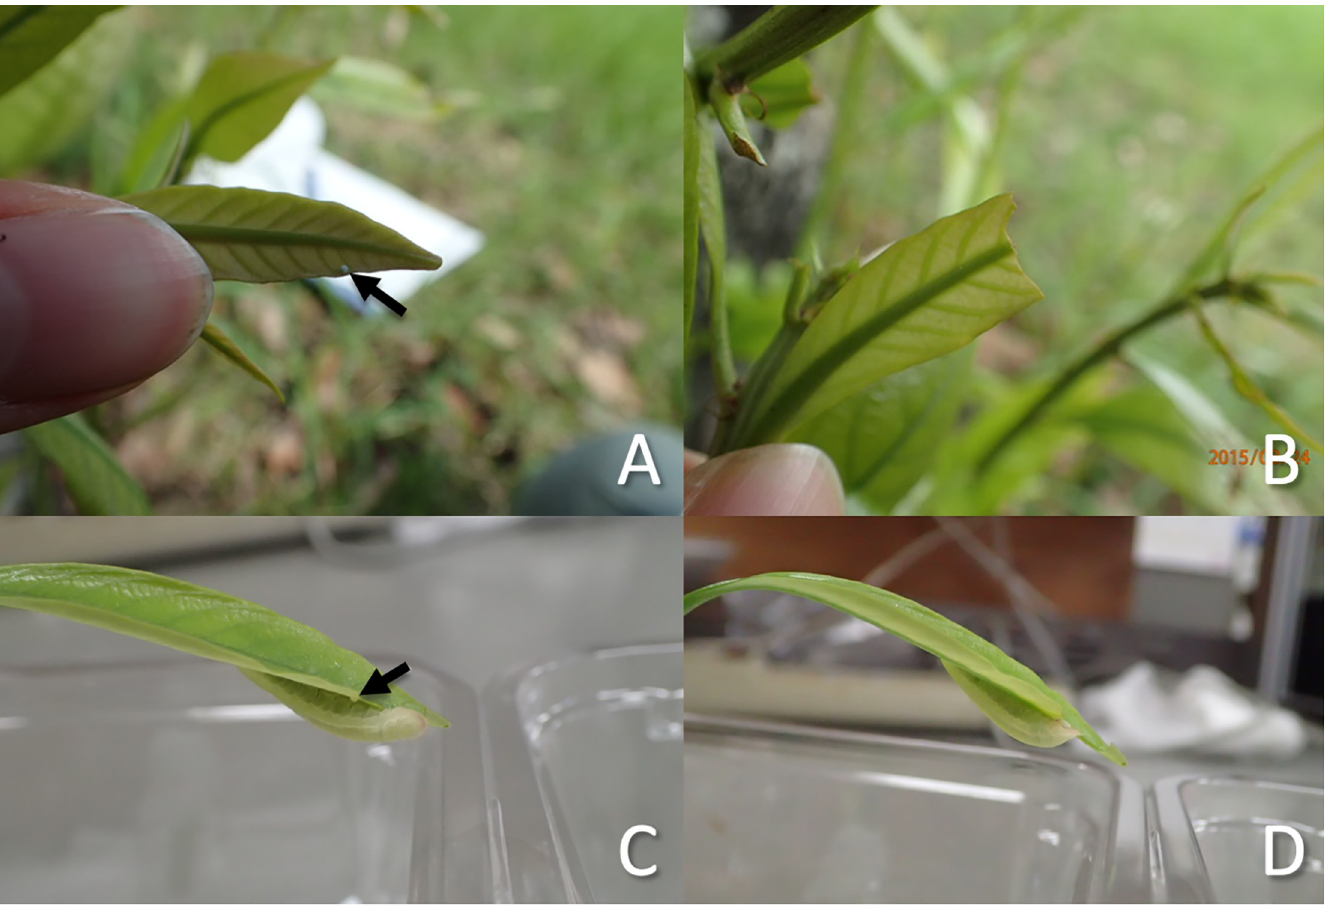
Fig 7. Examples of field (A-B) and laboratory (C-D) observations of A . bazalus eggs. (A) An A . bazalus egg (an arrow) laid on a young emerging L . edulis leaf, and (B) the same leaf, from which the apical part had been eaten and the egg was displaced after two days; a fifth instar A . bazalus larva (C) finding a conspecific egg (an arrow) on the host leaf and feeding on the surrounding leaf tissue and (D) displacing the egg by feeding on the surrounding leaf tissue.